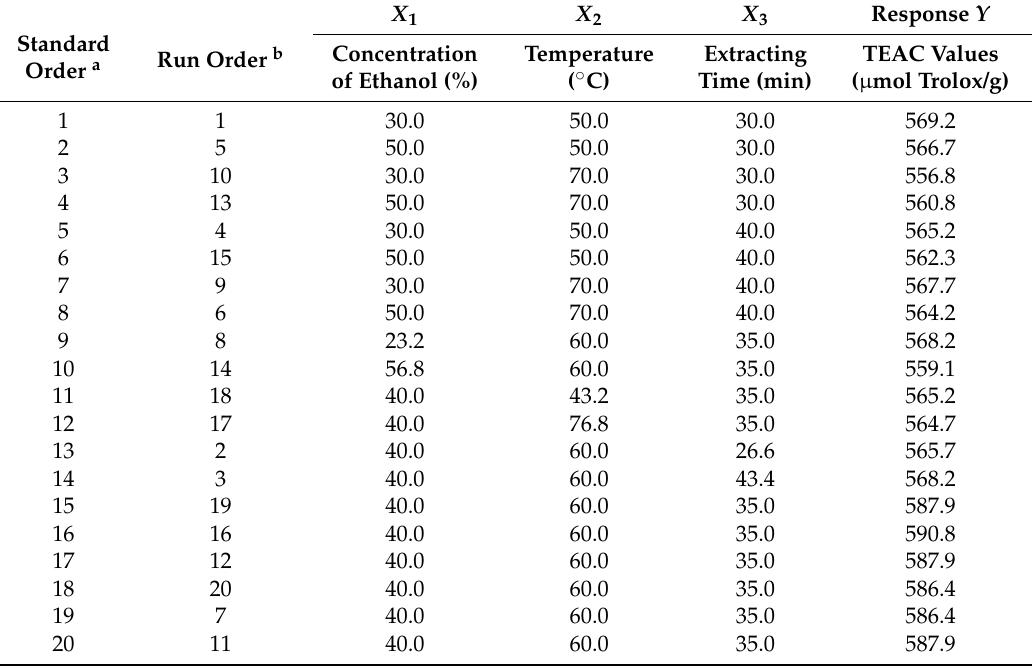
Table 2. The central composite design with experimental values of the investigated